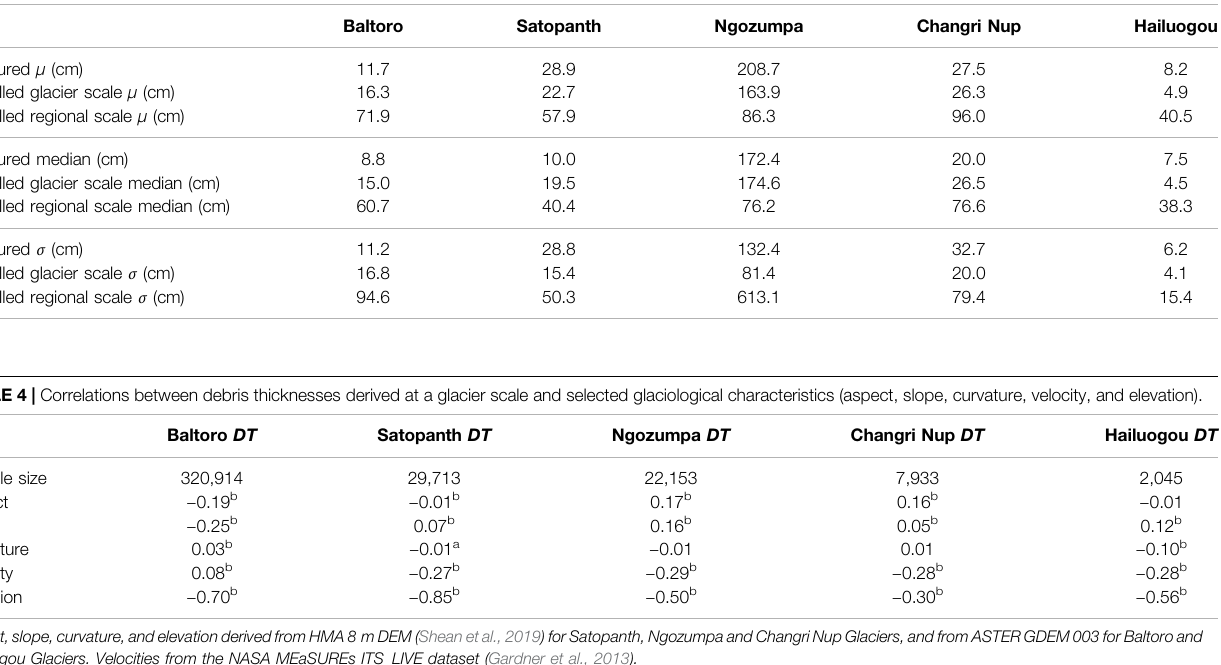
TABLE 3 | Comparison of the measured and modeled mean ( µ ), median and standard deviation ( σ ) debris thicknesses, at a glacier scale and at a regional scale.